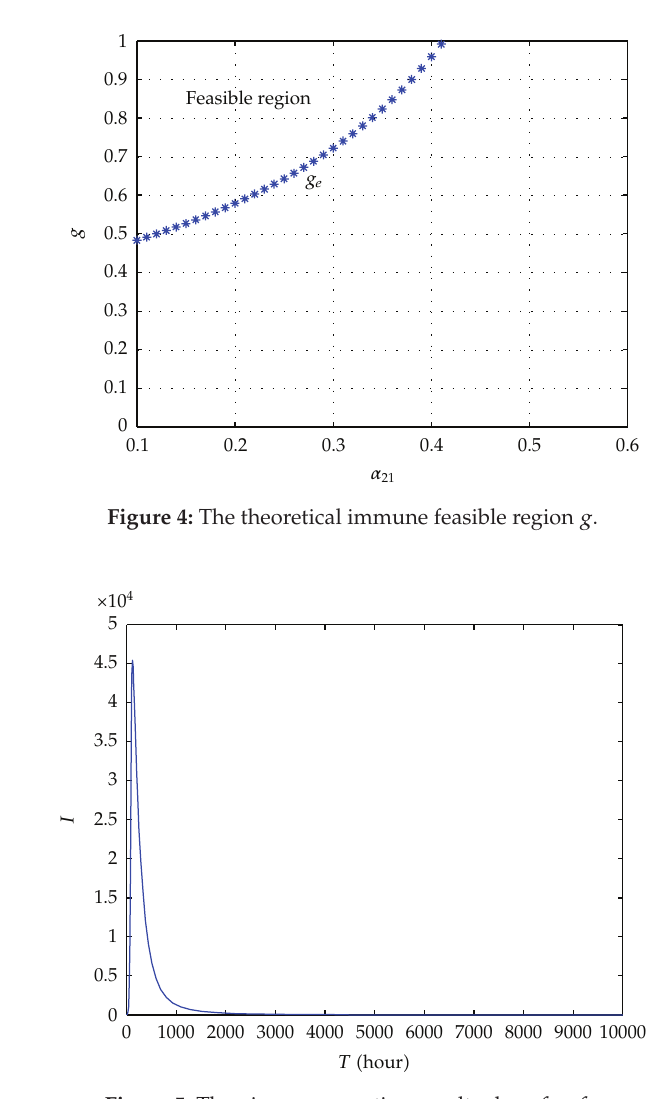
Figure 5: The virus propagation result when f > f e